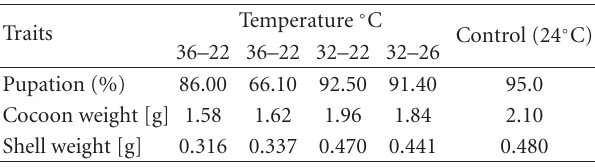
Table 2: E ff ect of temperature during late-age rearing on cocoon traits of